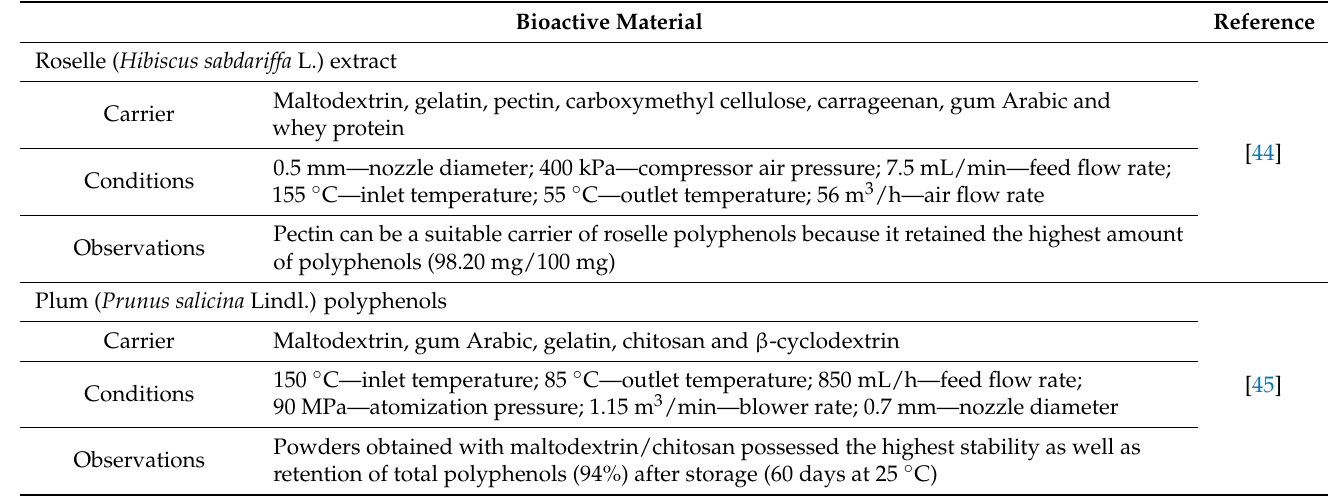
Table 1. Studies of spray-drying application for encapsulation of polyphenols from different